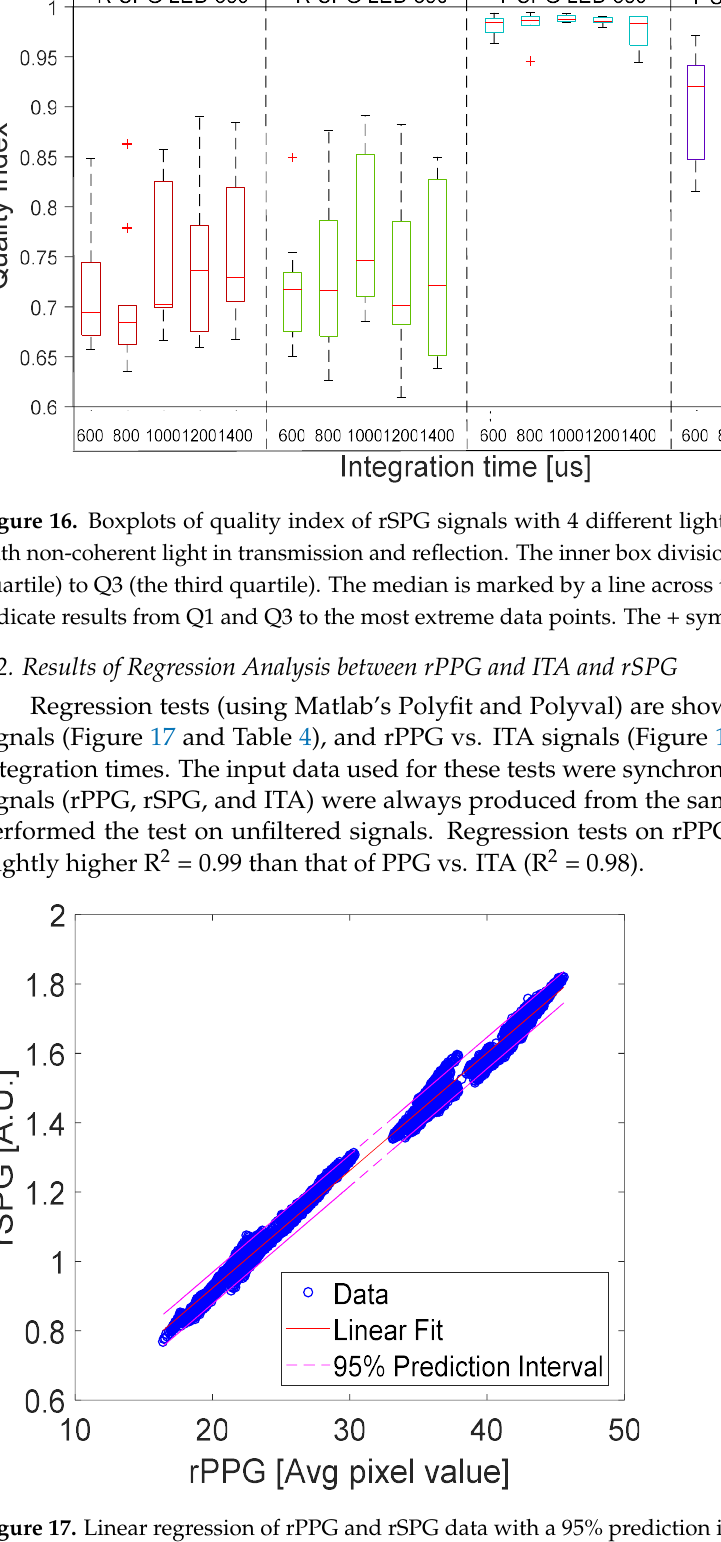
Figure 15. Boxplots of quality index of rPPG signals with 4 different lights at 5 integration times with non-coherent light in transmission and reflection. The inner box divisions indicate: Q1 (the first quartile) to Q3 (the third quartile). The median is marked by a line across the box. The “whiskers” indicate results from Q1 and Q3 to the most extreme data points. The + symbols represent outliers.